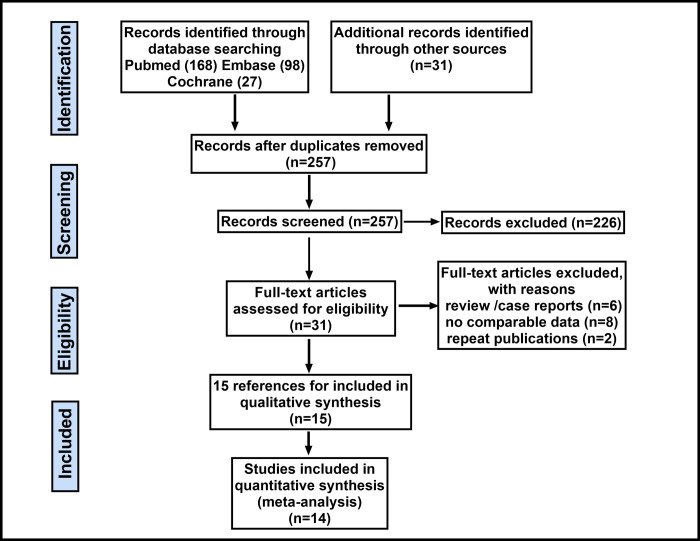
Flow diagram of the search results and study selection process.